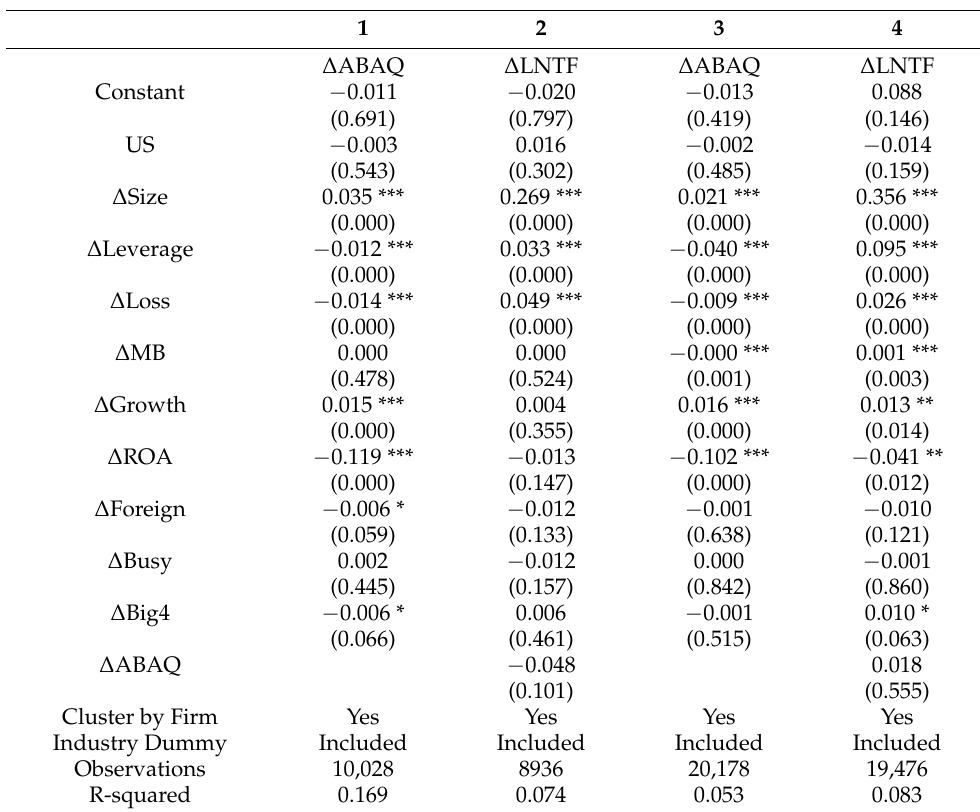
Table 6. Cont. Panel B: First-differenced data of U.S. and U.K.